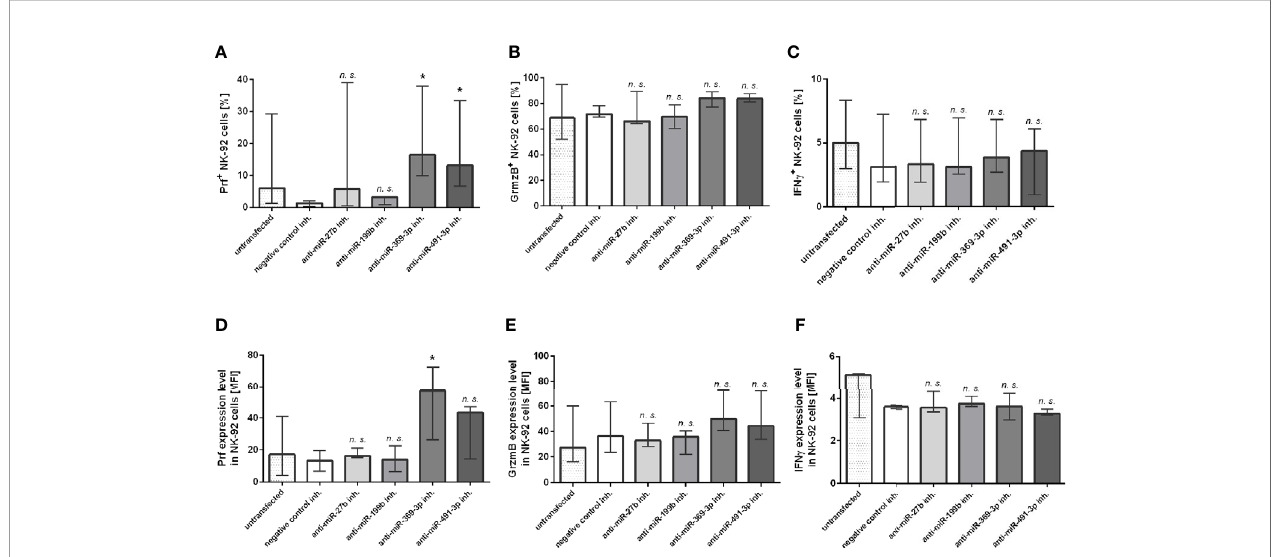
FIGURE 3 | Flow cytometry analysis. The effect of miR-27b, miR-199b, miR-369-3p and miR-491-3p inhibition in NK-92 cell line on perforin, granzyme B and IFN g expression analyzed using fl ow cytometry. The percentage of cells expressing perforin (A) , granzyme B (B) and IFN g (C) , and MFI of perforin (D) , granzyme B (E) and IFN g (F) is shown. The data of the effect of each speci fi c miRNA inhibitor was compared to negative control inhibitor. Data was analyzed using non-parametric Kruskal-Wallis test with Dunn ’ s post-hoc test for multiple comparisons. Data from 5 independent experiments, median and interquartile range are shown. Asterisks mark signi fi cant differences: *p < 0,05. inh., inhibitor; n. s., not signi fi